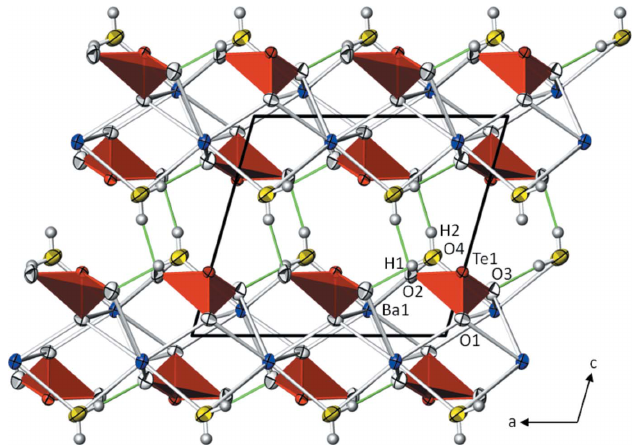
Figure 1 The crystal structure of BaTeO 3 (H 2 O) in a projection along [010]. Displacement ellipsoids are drawn at the 74% probability level. [TeO 3 ] trigonal pyramids are red, hydrogen atoms are of arbitrary size and O— H (cid:2)(cid:2)(cid:2) O hydrogen-bonding interactions are shown as green lines.